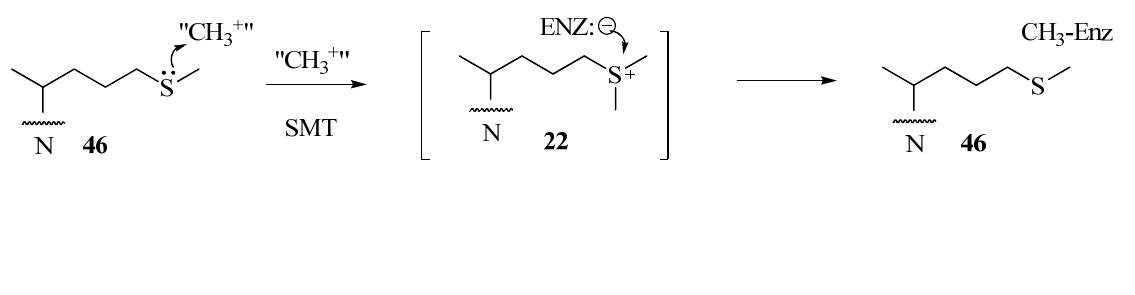
Figure 7. Proposed mechanism for the inhibition of C24-methylation activity by 46